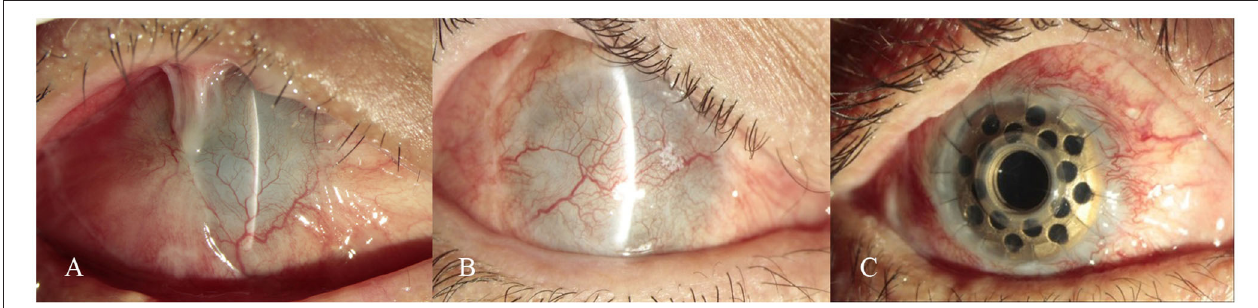
FIGURE 3 | (A) Extensive pseudopterygium covered half of the cornea, with severe symblepharon. (B) Symblepharon was completely released at 10 months after allogeneic CLET. (C) The best-corrected visual acuity (BCVA) had improved to 0.6 with a stable ocular surface at 6 months after implanting collar-button-shaped